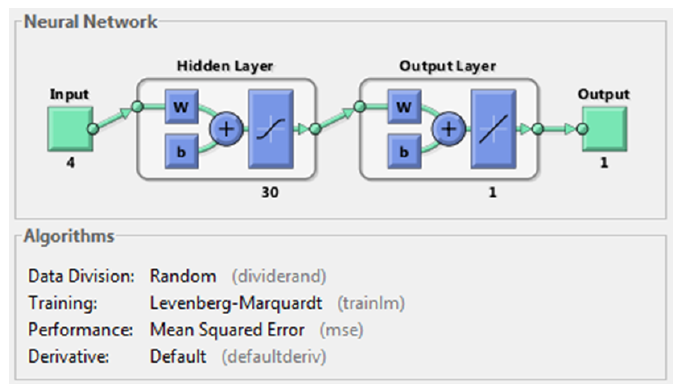
Figure 12. Screenshot of ANN configurations used for prediction of energy